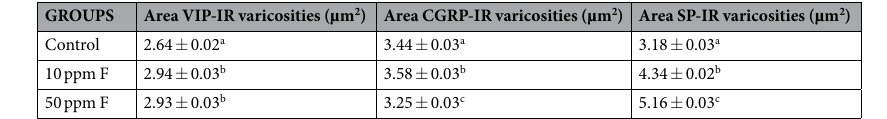
Table 4. Means and standard errors of the VIP-IR, CGRP-IR, and SP-IR values of myenteric neurons varicosities areas of the duodenum of rats exposed or not to F chronically, through the drinking water for 30 days. Animal groups: Control (deionized water–0 ppm F), 10 ppm F, and 50 ppm de F. Means followed by different letters in the same column are statistically different according to Tukey’s test (p < 0.05). n =